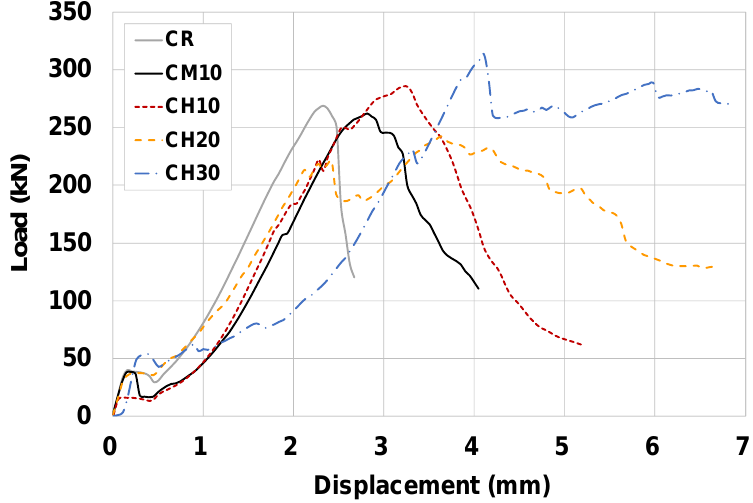
Figure 6. Comparison of load – displacement response of compressive strength test of specimen #1 for each variable.